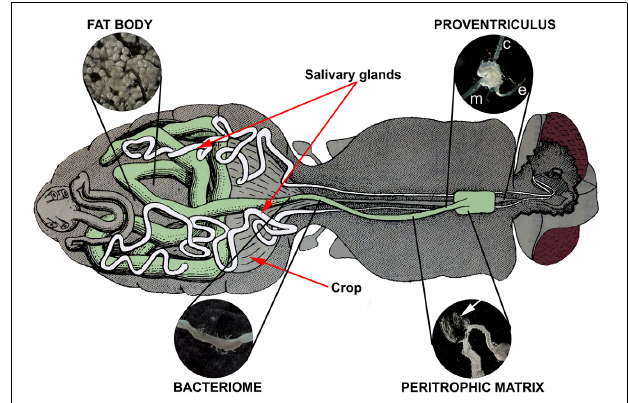
FIGURE 2 | Internal anatomy of the tsetse fly showing the tissues associated with fly refractoriness to parasite infection: proventriculus, peritrophic matrix, bacteriome, and fat body. Midgut-associated tissues (proventriculus, anterior midgut, bacteriome, mid and hindgut) are shaded in green. The fat body is dispersed throughout the abdomen; the inset depicts a characteristic grapelike cluster. The proventriculus encloses the junction between the esophagus (e), crop (c), and anterior midgut (m). A section of the peritrophic matrix is shown as a transparent sheath (arrow) extruding from a nicked anterior midgut (just posterior to the proventriculus). The bacteriome houses the primary endosymbiont Wigglesworthia glossinidia and is observed as a darker, flattened ring surrounding a section of the teneral midgut. The tsetse alimentary canal drawing was adapted from Roubaud (1909; Figure 84: Organization digestive de la Gl. palpalis